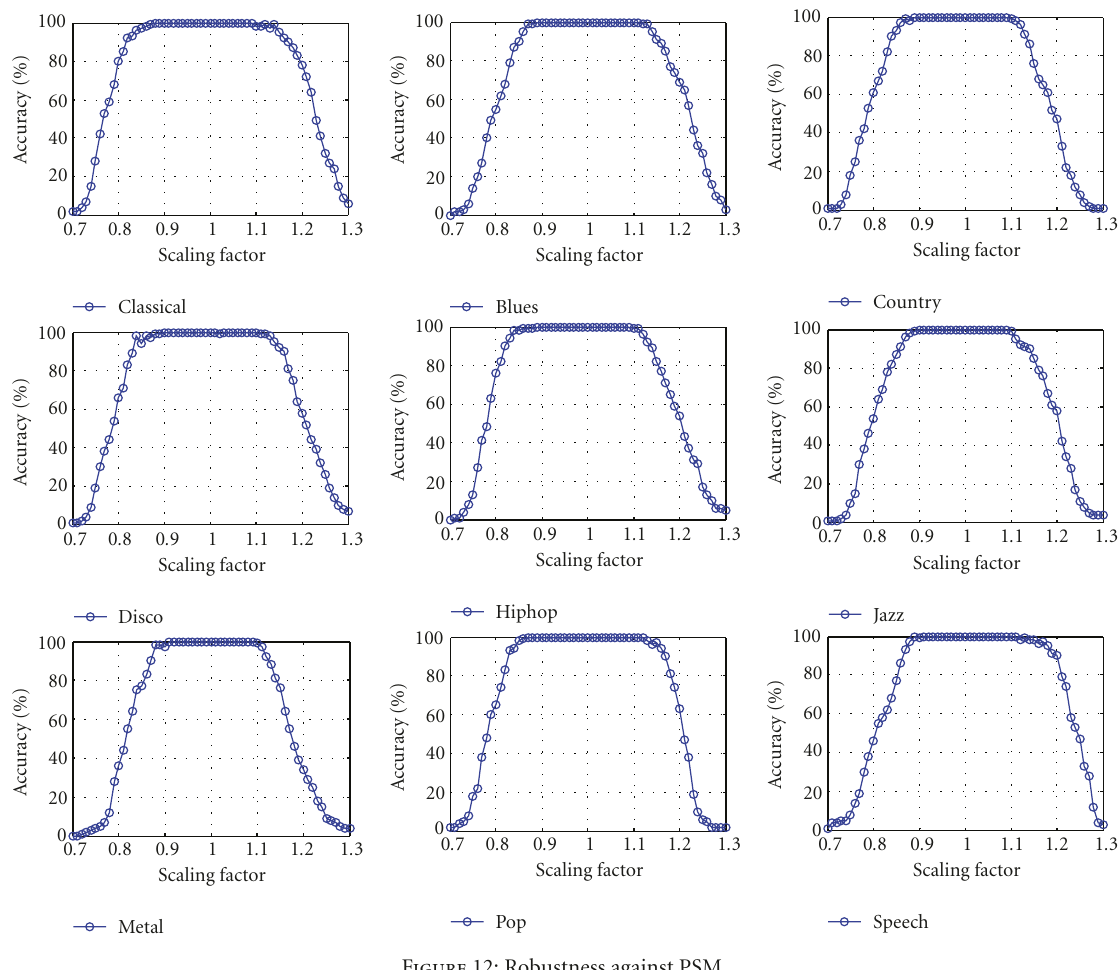
Figure 12: Robustness against PSM.